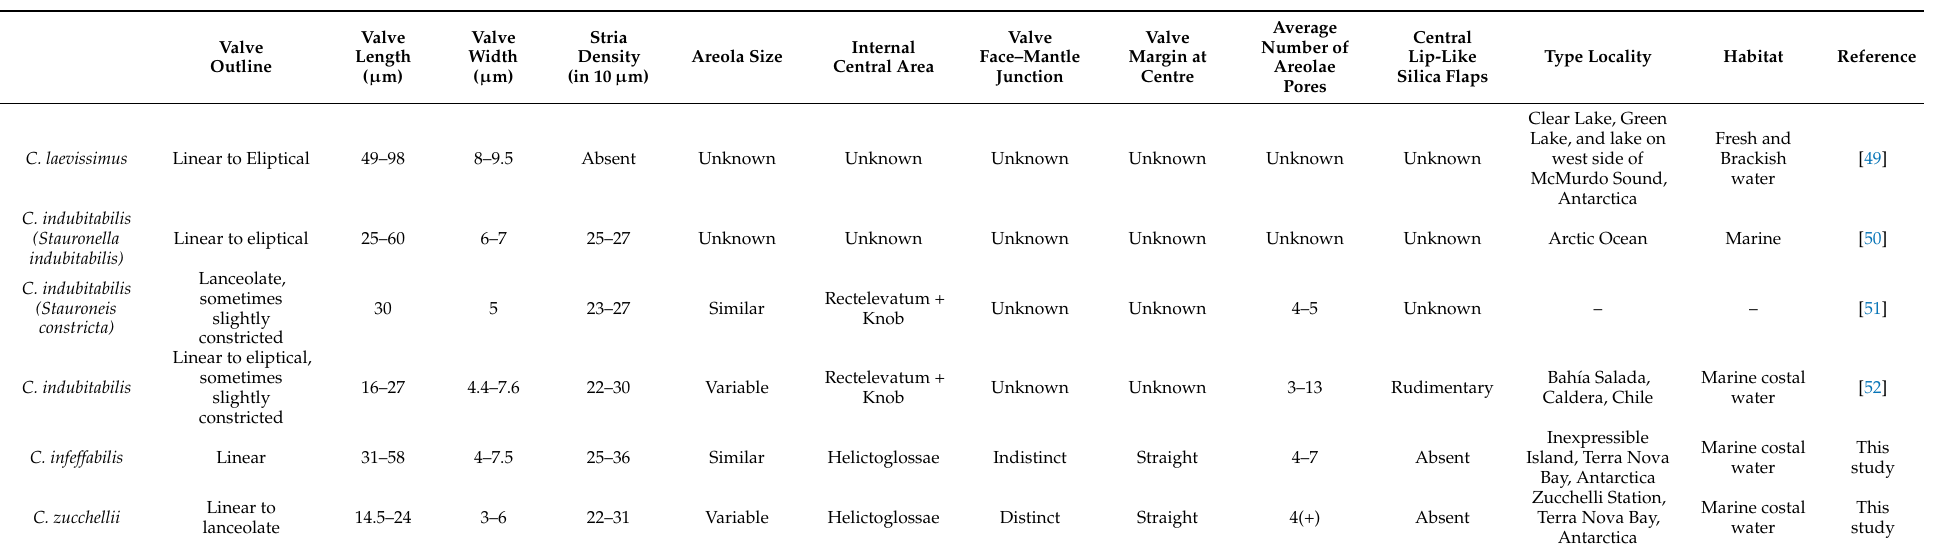
a Values and descriptions given in brackets refer to the Adriatic